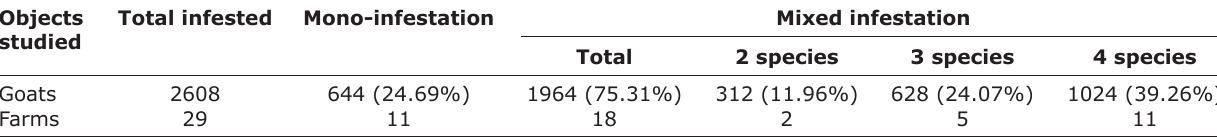
Table-4: Regional distribution of the mean intensity and mean extensity of invasion with bloodsucking Linognathus species in domestic goats. No.